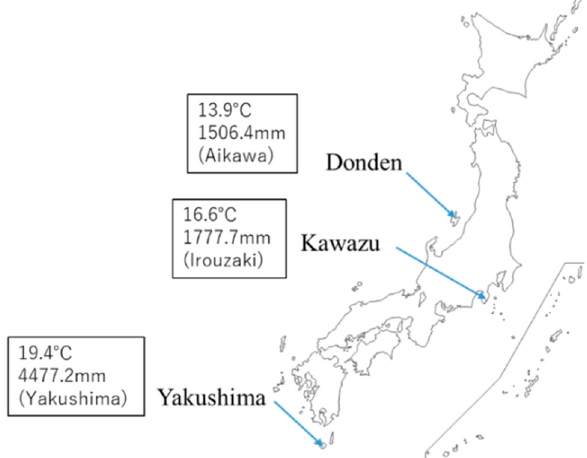
Figure 1. Collected area of the mother trees of three clones. Values in the box represent the annual mean air temperature and precipitation from 1981 to 2010 at the nearest weather station (in parentheses) [14].